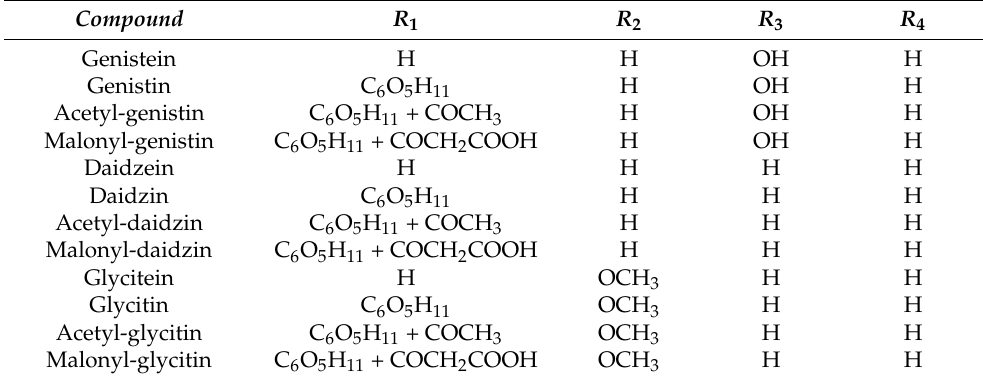
Table 1. Main isoflavone aglycones (genistein, daidzein, glycitein) and their isoforms.